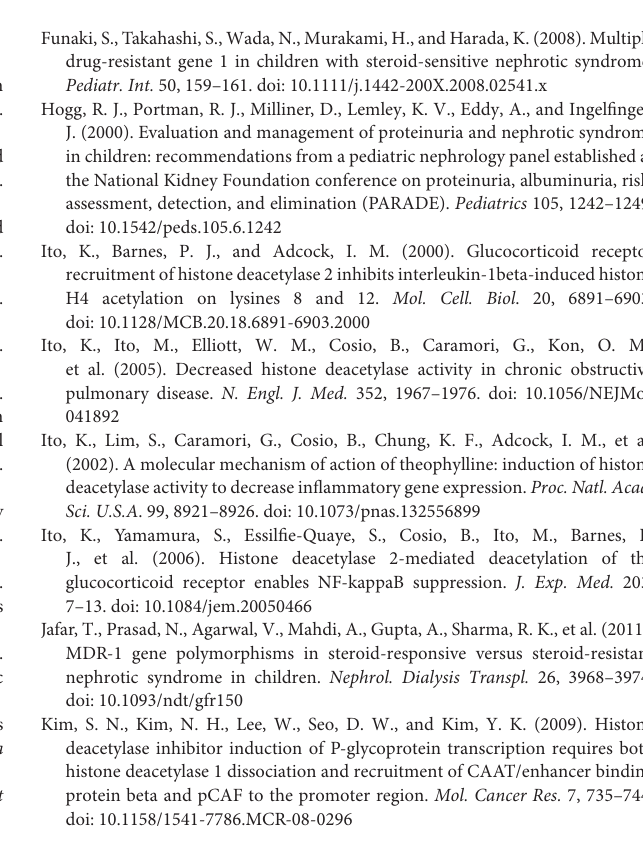
data of all the experiments are represented as mean ± SEM. Significant differences were indicated by p < 0.05. Supplementary Figure 2 | Expression of P-gp, MRP-1 and HDAC2 on unstimulated PBMCs of SRNS patients ( n = 4) during active disease and their subsequent remission. Peripheral Blood Mononuclear Cells were isolated from SRNS patients ( n = 4) during active disease and their subsequent remission. mRNA levels of P-gp, MRP-1 and HDAC2 were quantified by real-time PCR technique (A–C) . The experiments are representative of three independent series. Pooled data of all the experiments are represented as mean ± SEM. Significant differences were indicated by p < 0.05. Supplementary Figure 3 | Effect of Theophylline and on viability of PBMCs isolated from SRNS and SSSNS patients. (A,B) . Peripheral Blood Mononuclear Cells were incubated with increasing doses of HDAC2 stimulator and HDAC2 inhibitor. The experiments are representative of three independent series. Pooled data of all the experiments are represented as mean ± SEM. Significant differences compared to control were indicated by ∗ p < 0.05; ∗∗ p < 0.01. Supplementary Figure 4 | Effect of Trichostatin A on viability of PBMCs isolated from SRNS and SSNS patients (A,B) . Peripheral Blood Mononuclear Cells were incubated with increasing doses of HDAC2 stimulator and HDAC2 inhibitor. The experiments are representative of three independent series. Pooled data of all the experiments are represented as mean ± SEM. Significant differences compared to control were indicated by ∗ p < 0.05; ∗∗ p < 0.01. Supplementary Table 1 | Demographic and biochemical parameters of the patients with nephrotic syndrome. Supplementary Table 2 | Primer sequences for P-glycoprotein, Multidrug resistance-associated protein 1 (MRP-1), Histone Deacetylase2, Glyceraldehyde 3-phosphate